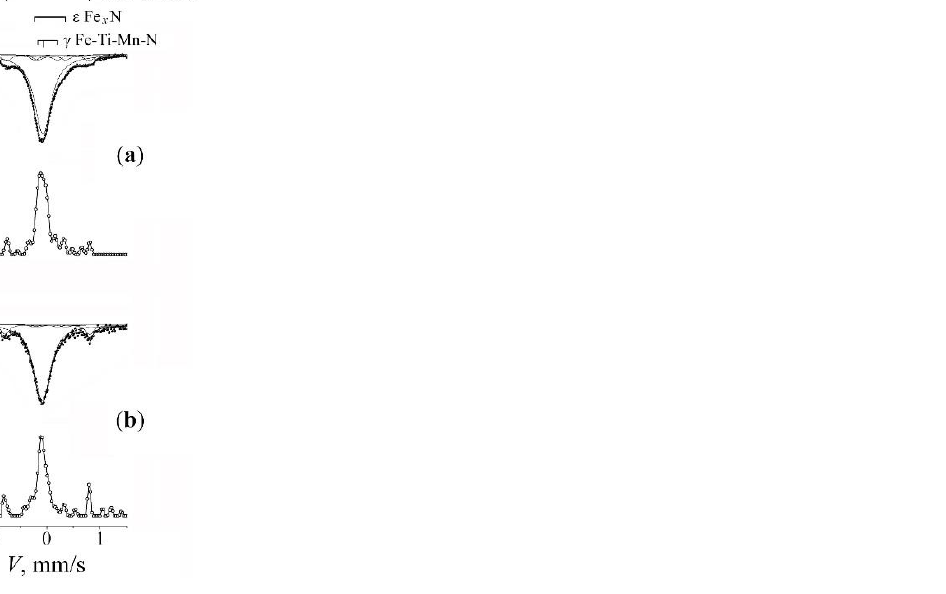
Figure 6. The central part of spectra for the mixture “ D ” (Fe – 5Ti + MnN) and the distributions p ( V ). Treatment: ( a ) — PBM, 10 h; ( b ) — PBM, 10 h + anneal 650 °C, 4 h.